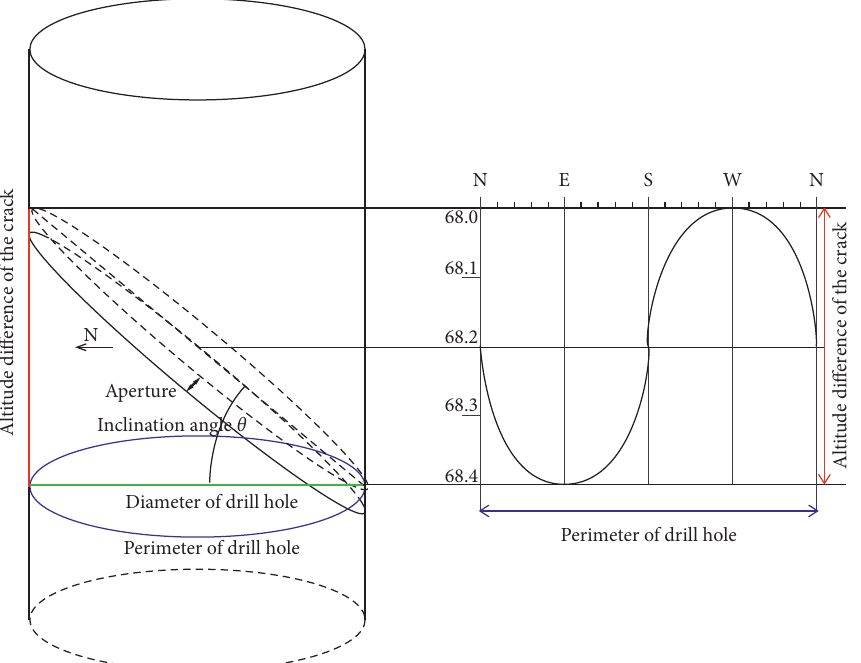
Figure 4: Schematic map of the borehole information extraction and calculation